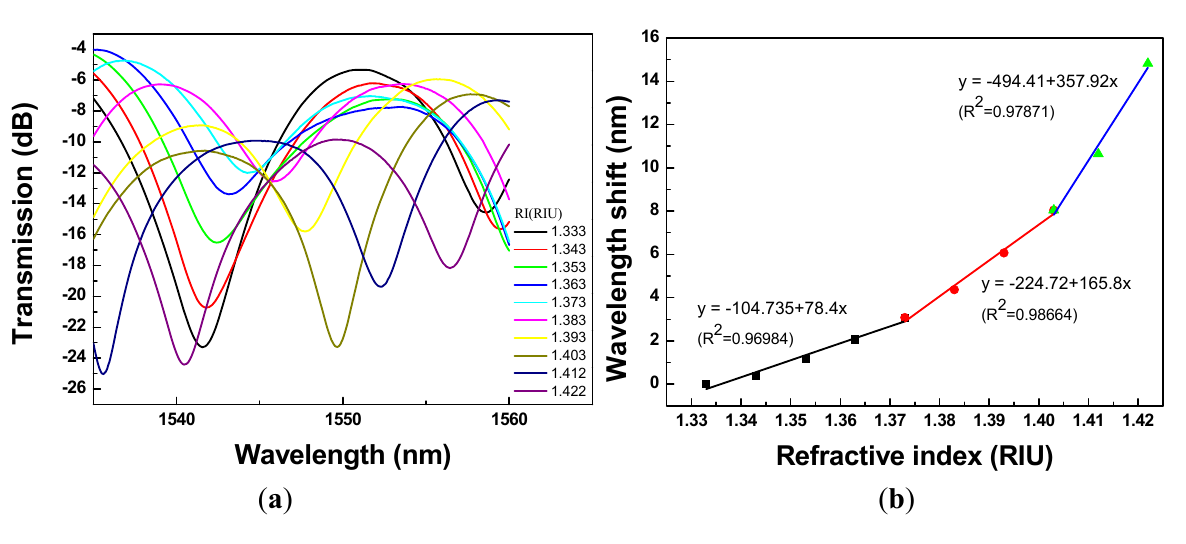
Figure 10. A 3.50-cm PCF interferometer with: ( a ) the transmission spectra for sensing different refractive indices of the sucrose solution (RI =1.333 − 1.422); ( b ) the relationship between wavelength shift and refractive index (resonance wavelength = 1,541.56 nm).